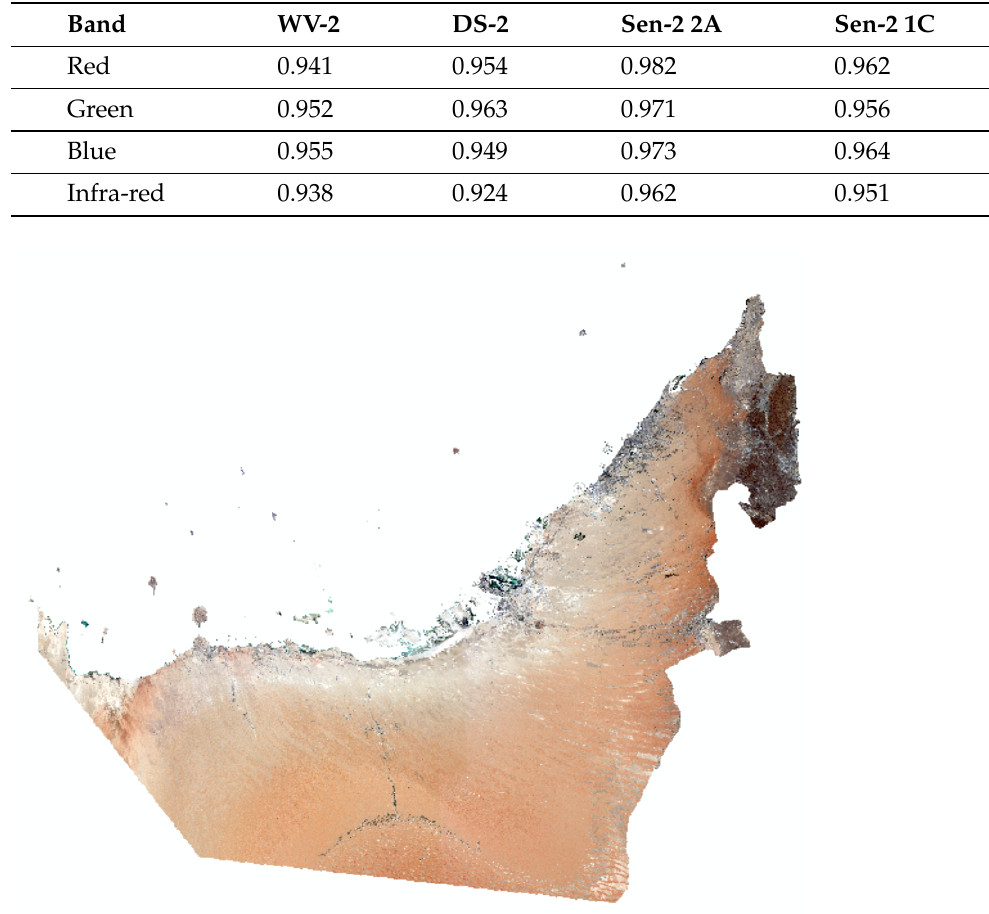
Figure 8. The mosaic of UAE developed using the proposed approach on Sentinel-2 Level 2A